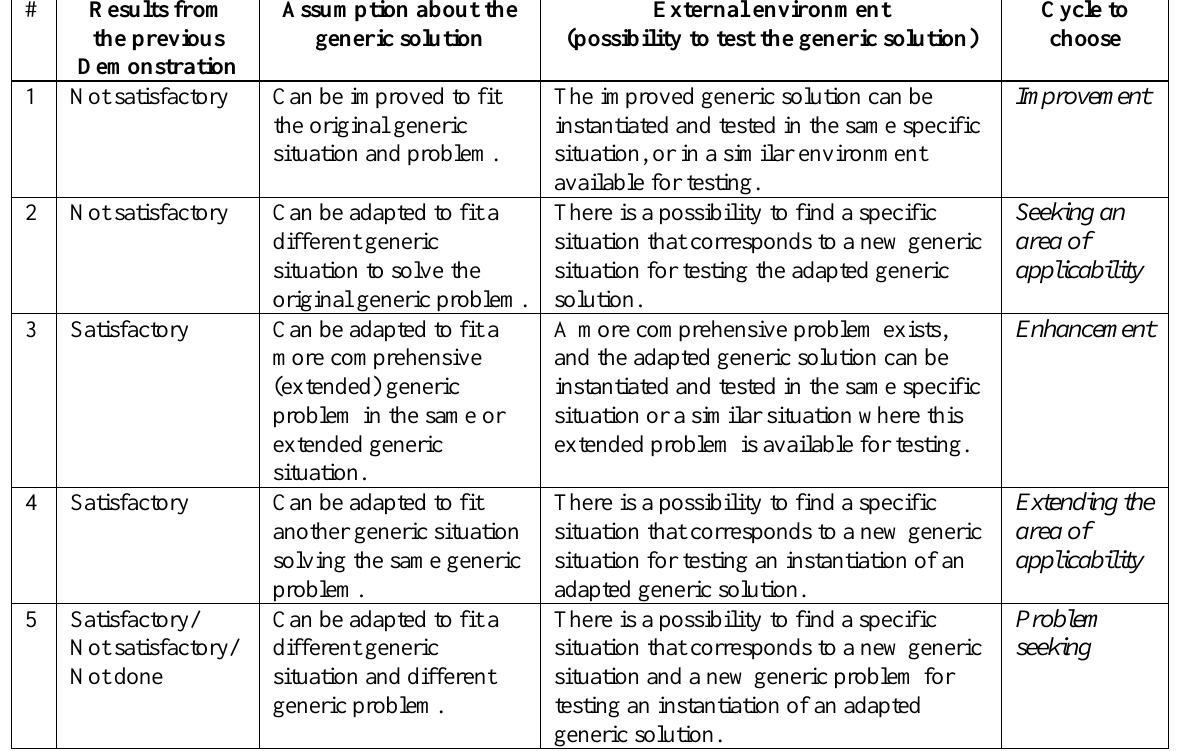
Table 3. Pragmatic rules for choosing the next